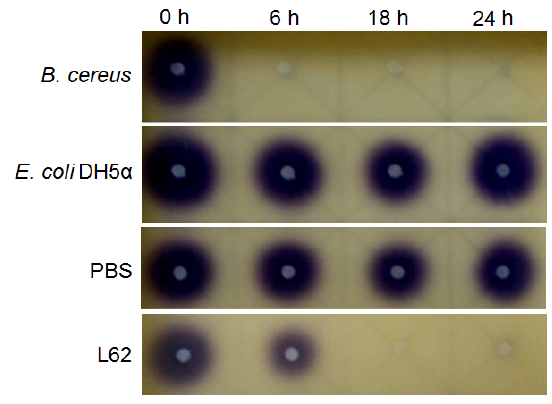
Figure 3. Degradation of 3-oxo-C6-HSL by B. sonorensis. Disappearance of 3-oxo-C6-HSL was revealed by decreased or loss of purple pigmentation on the biosensor C . violaceum CV026 lawn. From left to right, degradation of 3-oxo-C6-HSL investigated at 0, 6, 18, and 24 h. Rows from top to bottom: B. cereus (positive control), E. coli DH5 α (negative control), PBS (extraction buffer, negative control), and L62 ( B. sonorensis